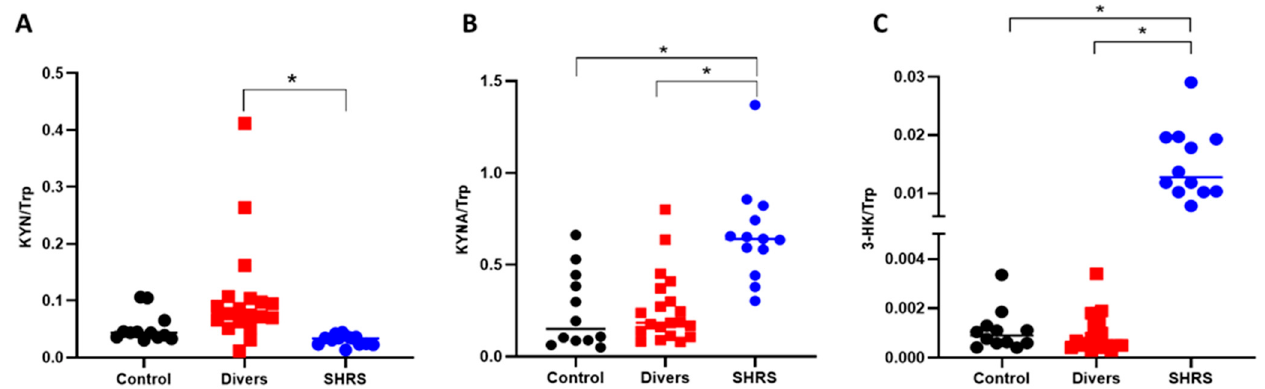
Figure 3. Effect of different types of exercise on serum KP ratios: control ( n = 12), diver ( n = 20) and SHRS ( n = 14) groups. ( A ) KYN/Trp ratio, ( B ) KYNA/Trp ratio and ( C ) 3-HK/Trp ratio. Data are represented by the median. * p < 0.05 based on the Kruskal–Wallis test with Dunn’s test for multiple pairwise comparisons.